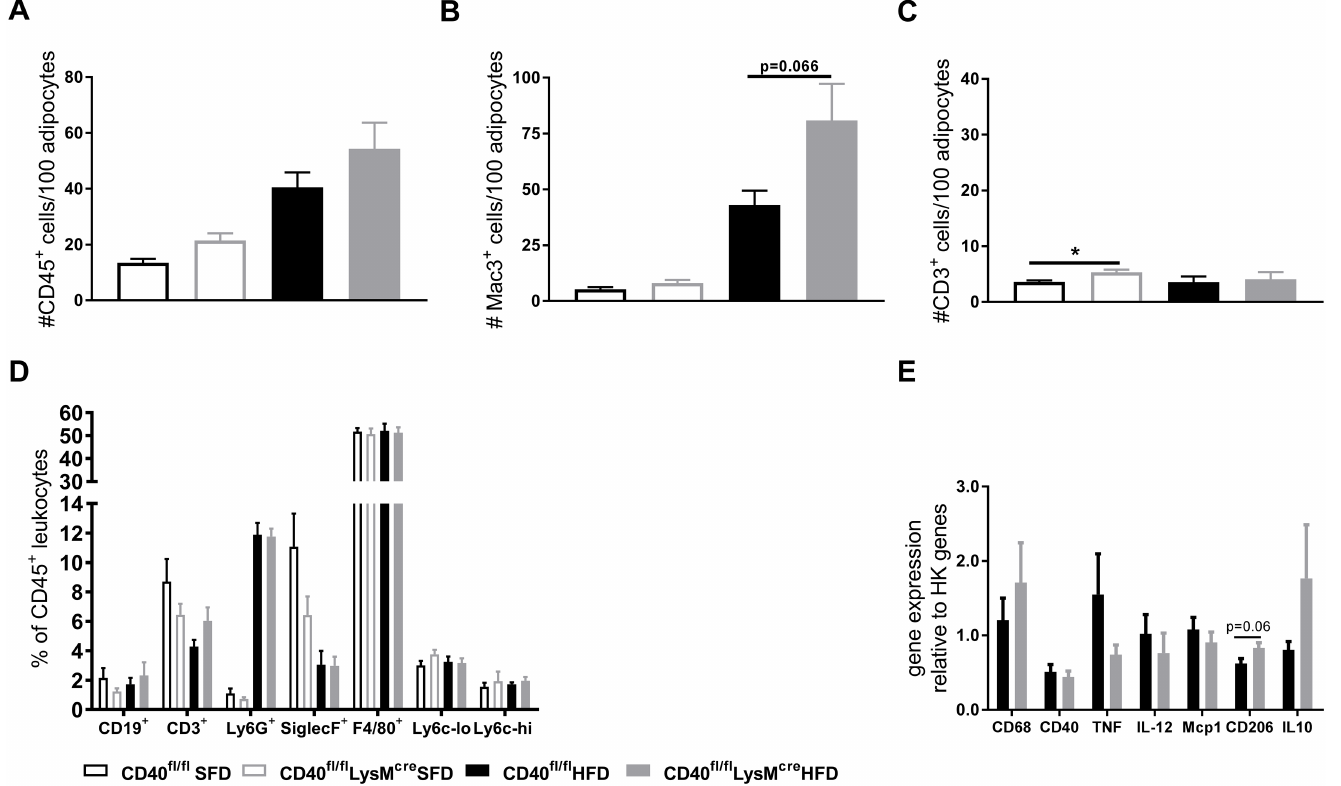
Fig 4. Adipose tissue inflammation is slightly increased in macrophage CD40 deficient mice without resulting in altered cytokine release. (A) Quantification of CD45 staining for leukocytes of EpAT (n = 16 for HFD and n = 7 for SFD). (B) Quantification of Mac3 staining for macrophages in EpAT (n = 16 for HFD and n = 7 for SFD). (C) Quantification of CD3 + staining for T cells in EpAT (n = 16 for HFD and n = 7 for SFD). (D) Flow cytometric analysis of leukocyte subsets in EpAT, as % of total CD45 + leukocytes (n = 7-9/group). (E) mRNA expression of inflammatory markers in EpAT (n = 7-9/group). Data is presented as mean ±